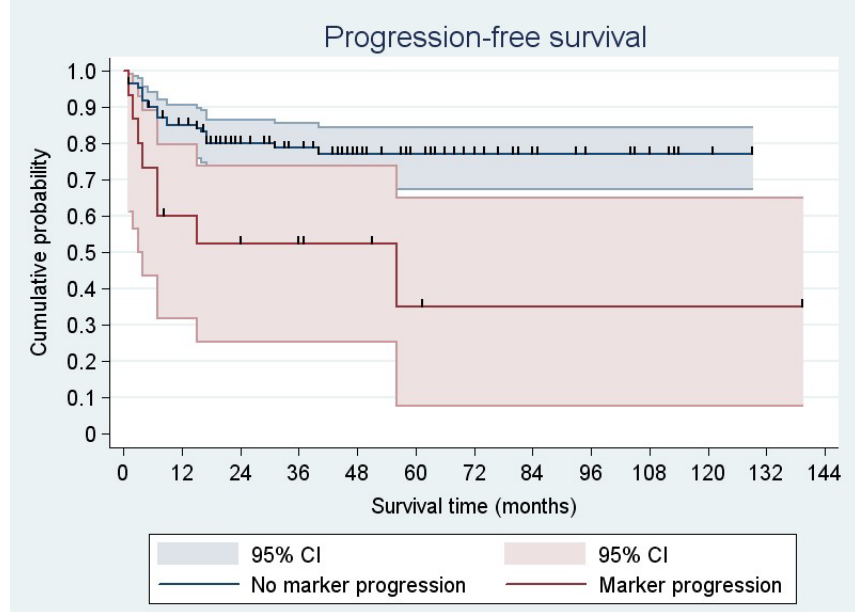
Kaplan-Meier analysis of progression-free survival after stratification for serological progression prior to PC-RPLND. Tumor marker stable or decreasing progression-free survival at 5 years 77% (95% CI: 67–84%);